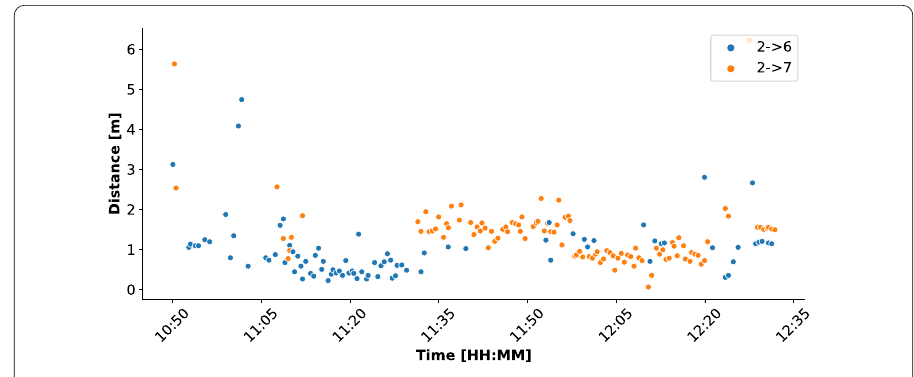
Table 1 Description of the three summer camps investigated in our study ID Short Description Ages Children Educators Groups AM - PRI Morning camp with a large indoor space, nearby a public park. All day camp in an alpine region with only outdoor